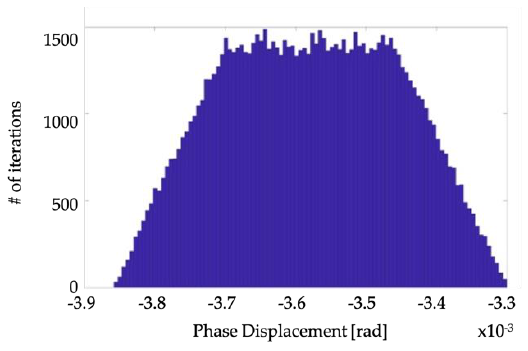
Figure 6. PDF of the  calculated from the metrological characterization of the items.